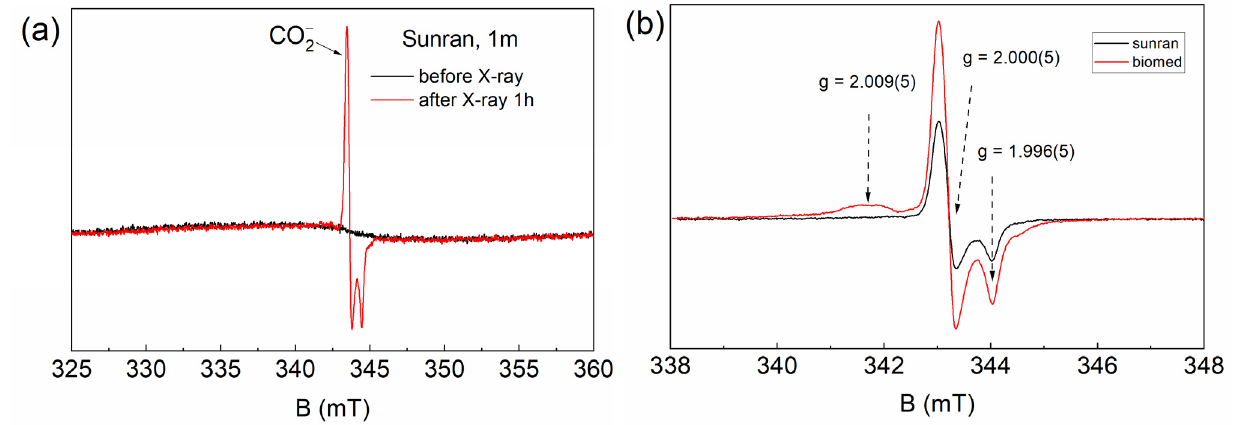
Figure 2. EPR spectra of bone tissue samples before irradiation depending on the implantation system after one month of installation.